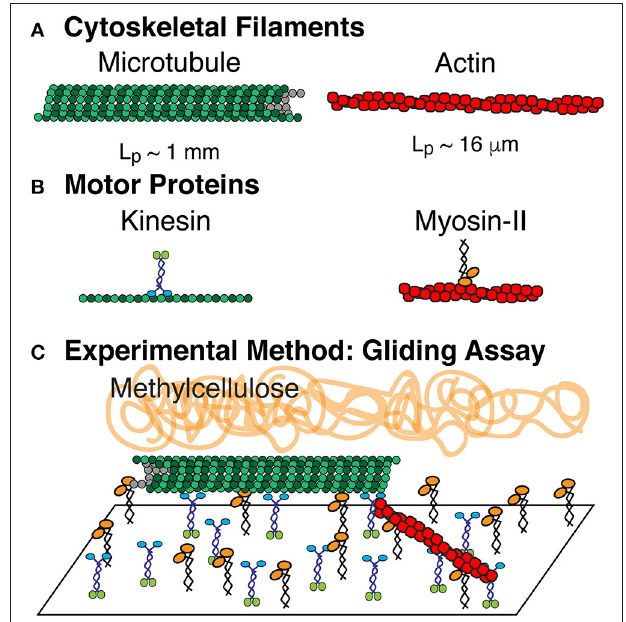
FIGURE 1 | Composite driven active rod experiments. (A) The rods are composed of microtubule and actin filaments, which are polymerized from tubulin dimers and globular actin monomers, respectively. (B) Microtuules are driven by the ATP turn-over of kinesin-1 motor proteins. Actin filaments are driven by the ATP turn-over of myosin-II motor proteins. Both motors are truncated forms. Kinesin-1 is truncated at amino acid 560 and expressed in bacteria. Myosin-II is enzymatically cleaved to make heavy meromyosin (HMM) and purified from chick muscles. (C) Active rod experiments performed in a filament gliding assay. Kinesin-1 and myosin-II are both adhered to the cover glass. Microtubules and actin filaments are added to the chamber where